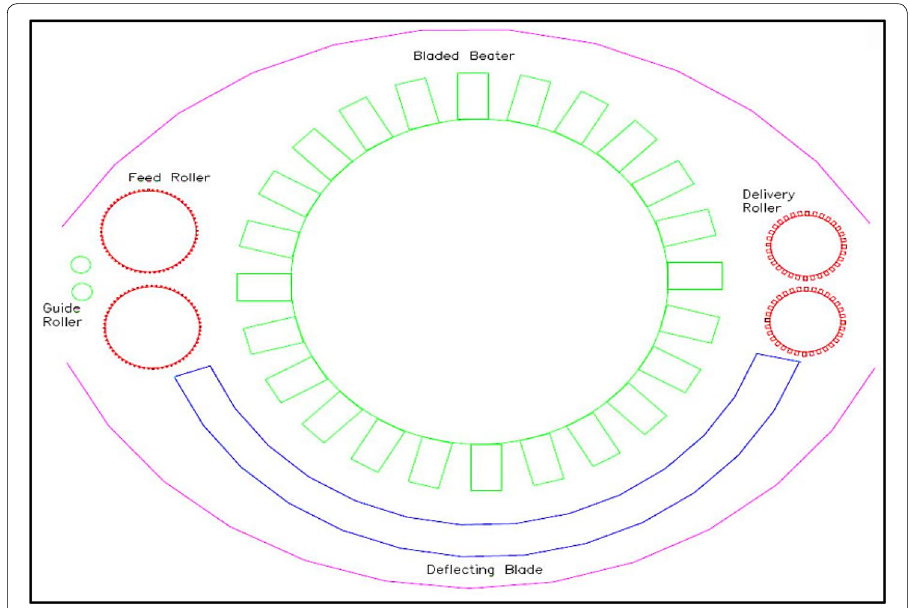
Fig. 1 Line diagram of banana fiber extractor machine